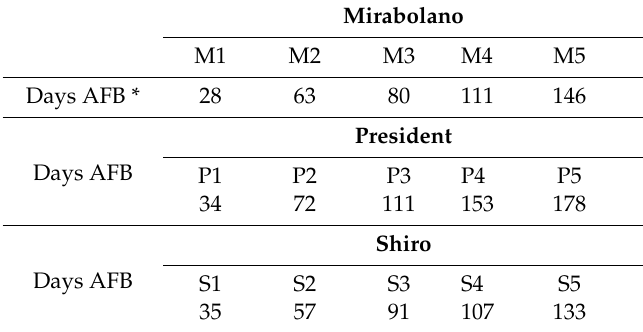
Table 1. Stages of development of the plum